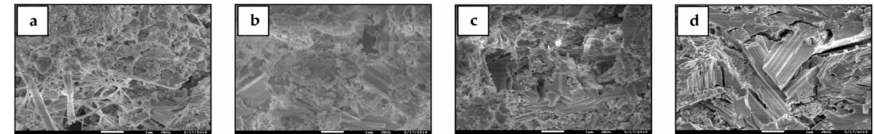
Figure 17. SEM micromorphology of GF-HBSAC cement hydration products at di ff erent curing ages: